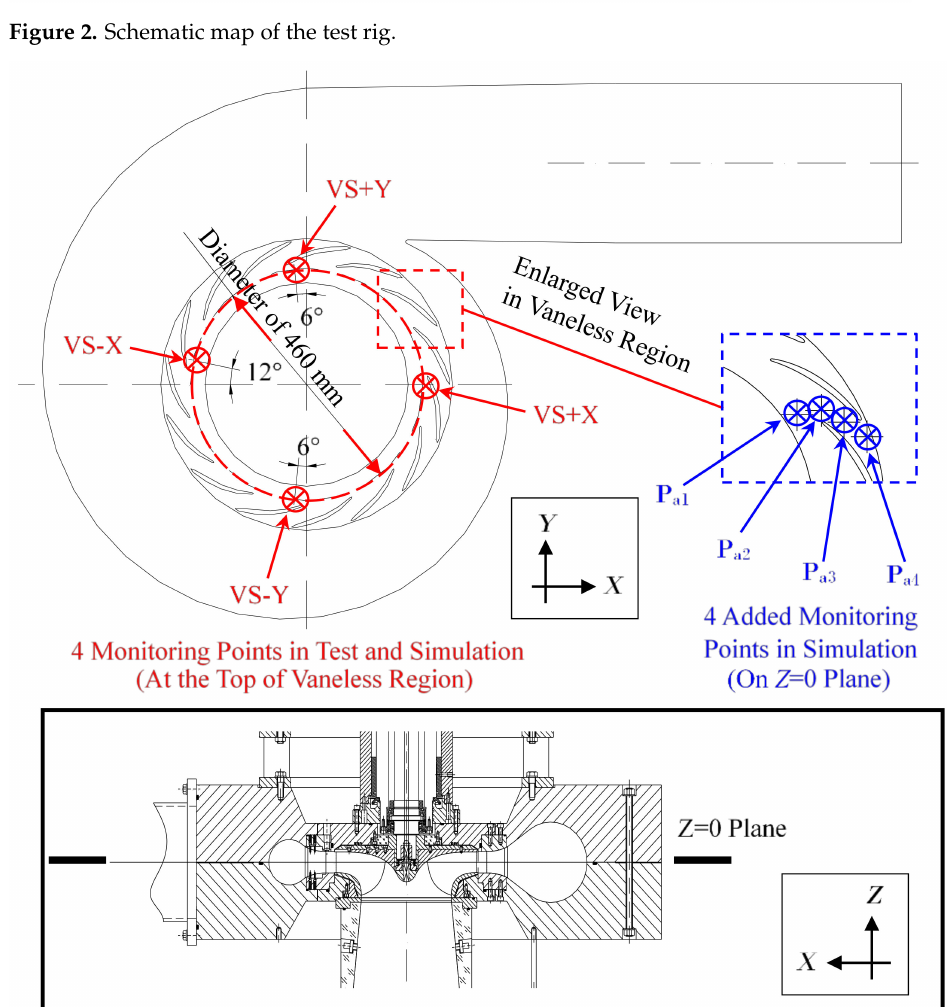
Figure 3. Pressure-pulsation monitor points in the model, test, and numerical